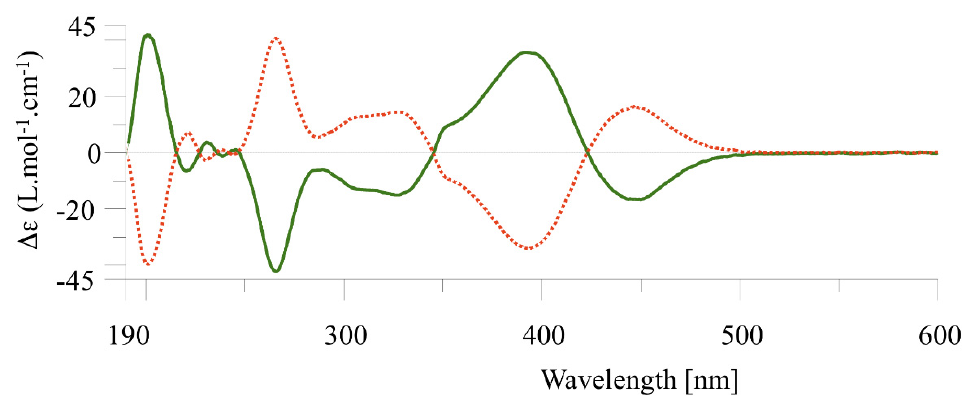
Figure 2. CD spectra of ( S )- 2 (green) and ( R )- 2 (red) recorded in CH 3 CN at 0.251 mM.